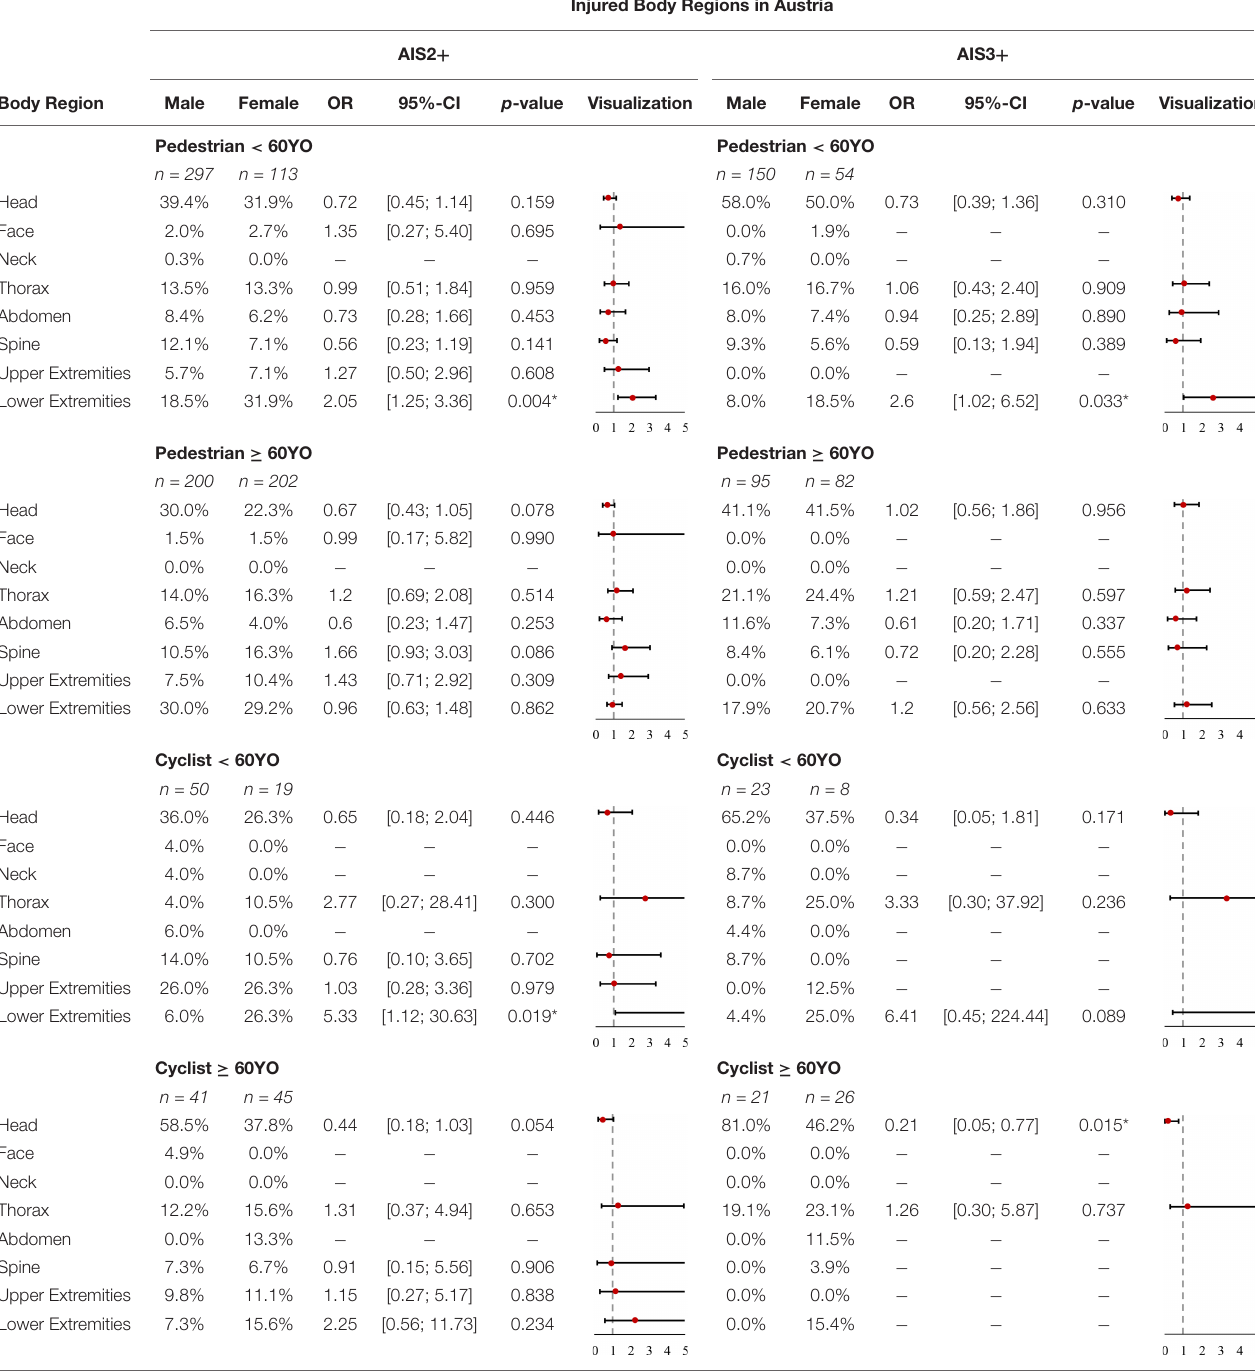
TABLE 4 | Share of injured body regions for AIS2 + and AIS3 + injuries, OR and p -value in Austria for pedestrians and cyclists < 60YO and ≥ 60YO (* p -value < 5%). Injured Body Regions in